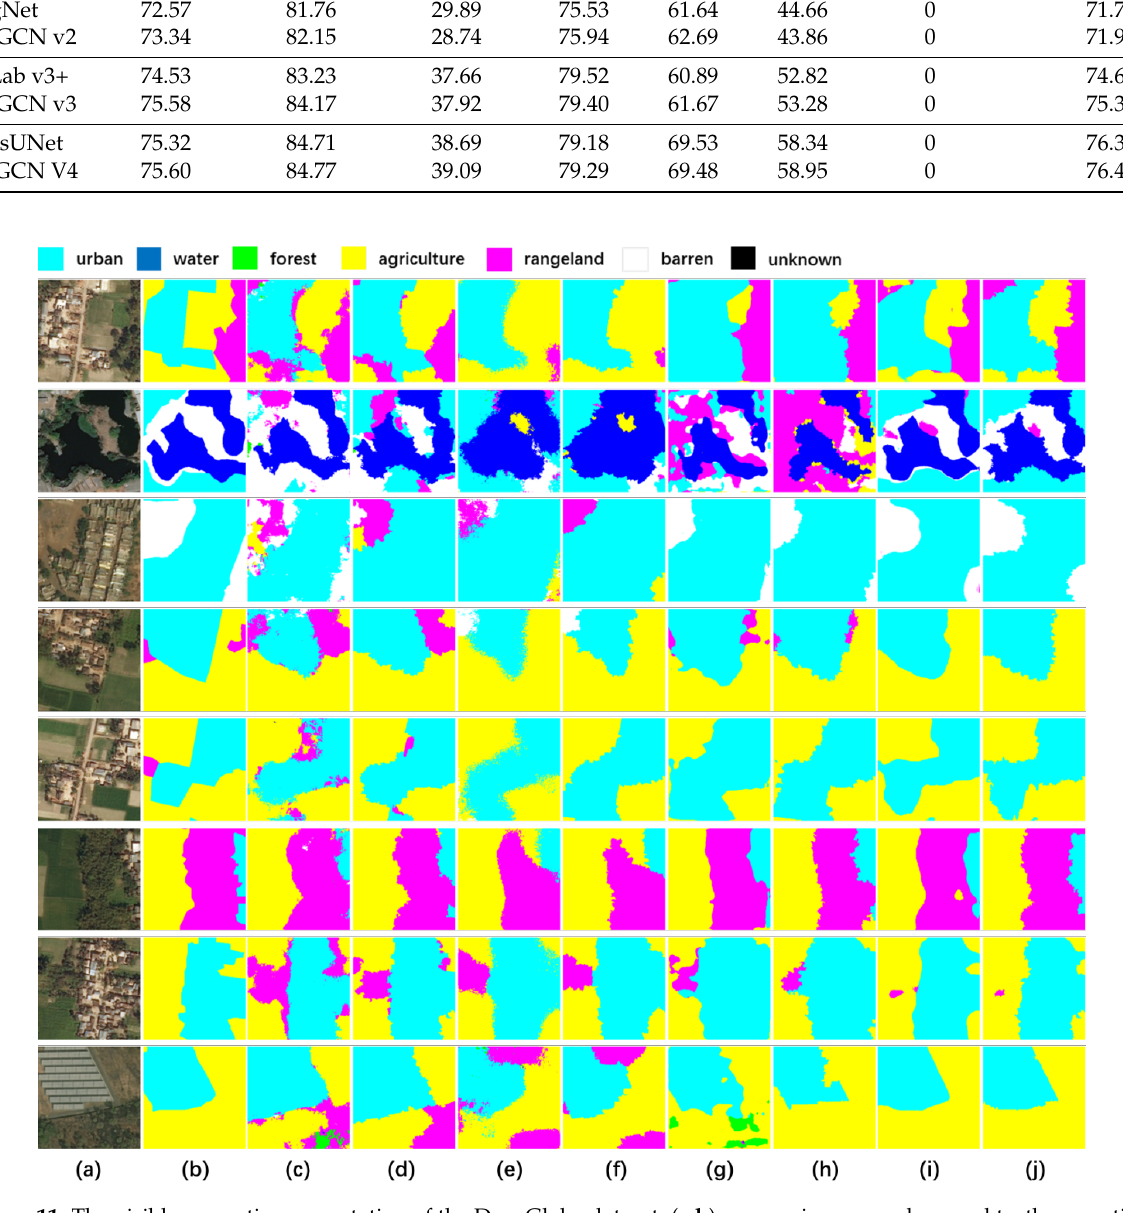
Figure 11. The visible semantic segmentation of the DeepGlobe dataset. ( a ) and ( b ) are raw images and ground truth respectively. ( c ) and ( d ) are the results of U-Net and the results of DSSN-GCN V1, respectively. The results of SegNet and the results of DSSN-GCN V2 are shown on ( e ) and ( f ), respectively. ( g ) and ( h ) present the results of DeepLab V3+ and the results of DSSN-GCN V3, respectively. The results of the proposed AttResUNet and AttResUNet-GCN (DSSN-GCN V4) are displayed on ( i ) and ( j ), respectively.